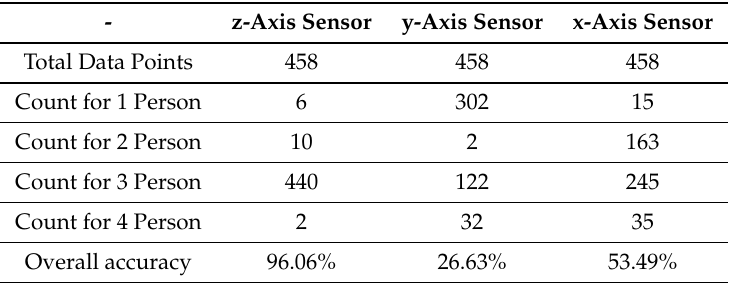
Table 3. Window size: three people sitting.